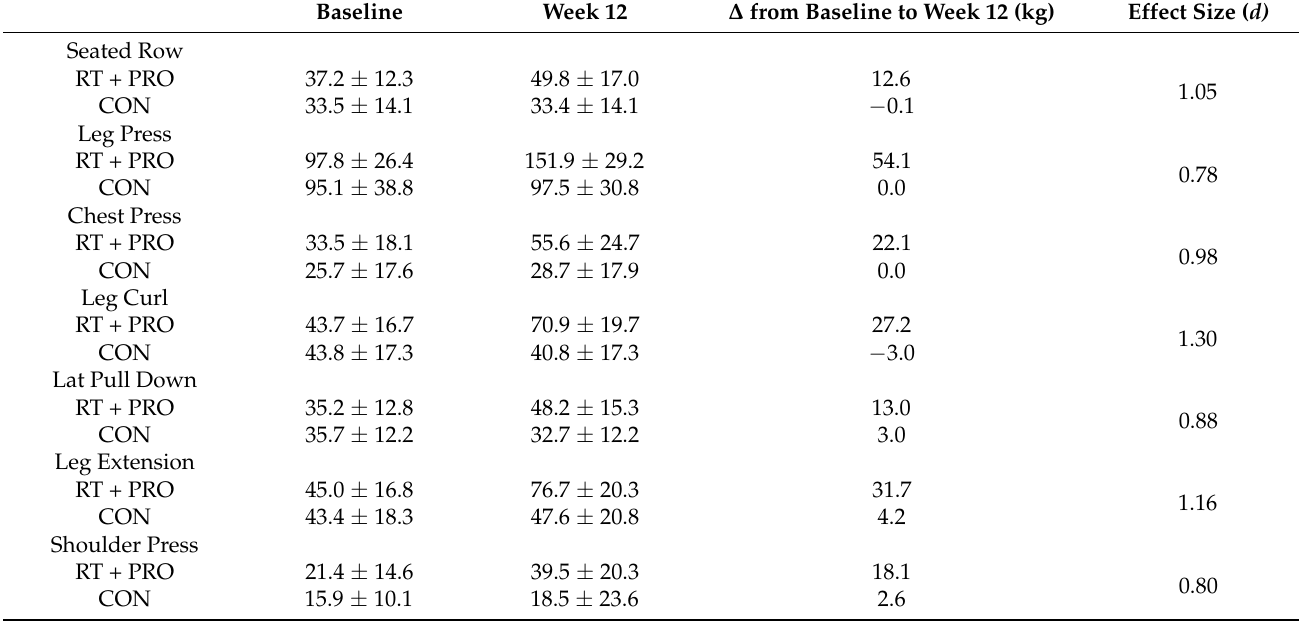
Table 7. Maximum Strength scores from 5-RM, change from baseline to Week 12 in RT + PRO and CON. Baseline Week 12 ∆ from Baseline to Week 12 (kg) Effect Size (